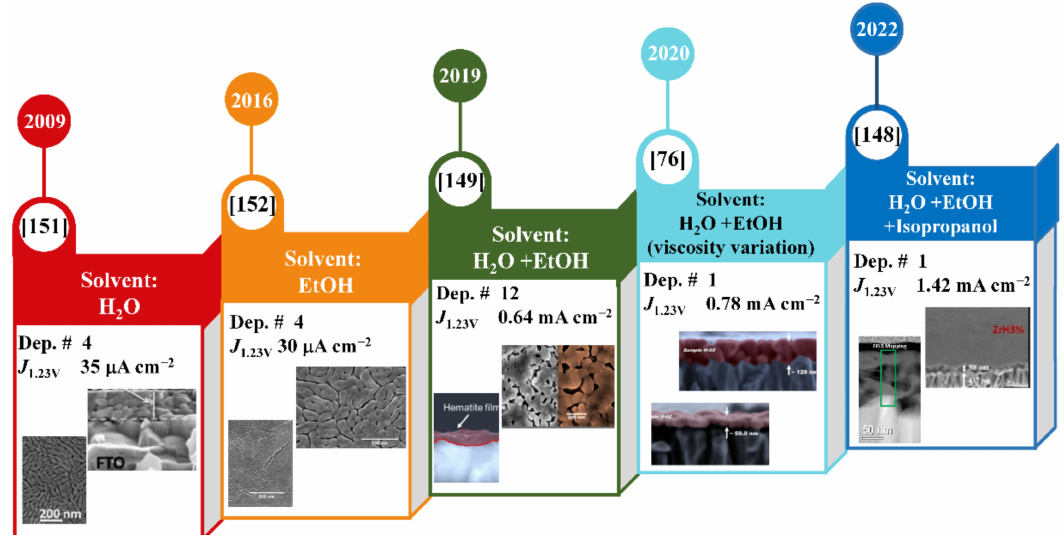
Figure 5. Timeline of significant breakthroughs in the synthesis of spin-coated hematite photoanodes by the polymeric precursor method from 2009 to 2022. The deposition number is represented by Dep # , and the J 1.23V represents the photocurrent density obtained at 1.23 V vs. reversible hydrogen electrode (RHE). Reprinted from Reference [151], Copyright 2009; Reference [152], Copyright 2016; Reference [149], Copyright 2019; Reference [76], Copyright 2020; Reference [148], Copyright 2022, with permission from